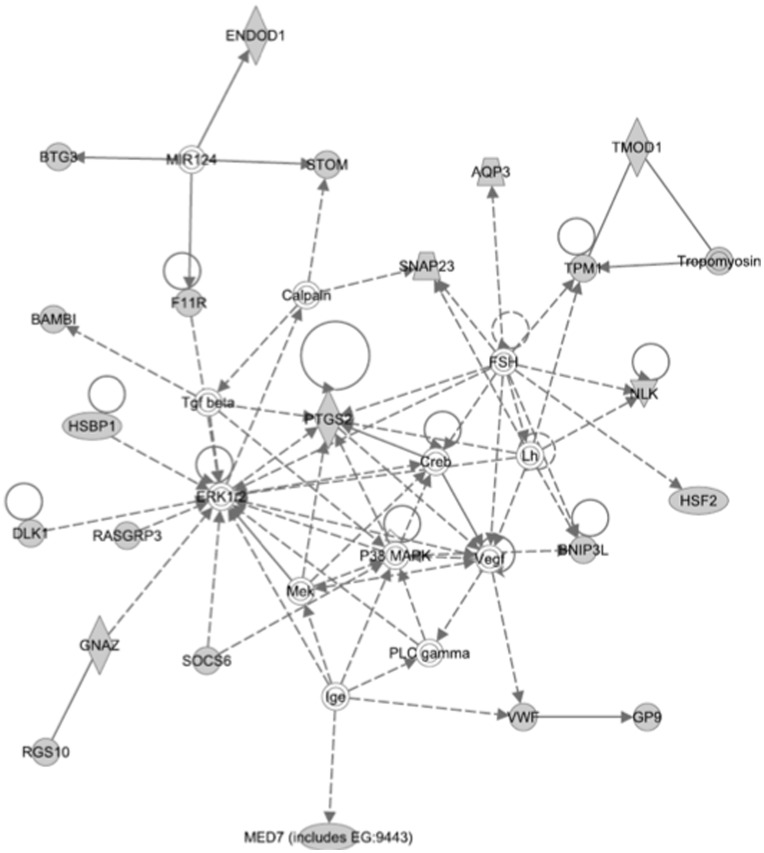
Second-highest scoring network after interactive network analysis of gene expression changes induced after hep-ATIII treatment of SIV-infected rhesus macaques.The second-highest scored network activated by hep-ATIII treatment of chronically SIV-infected rhesus macaques, at a time point when viral replication is inhibited by hep-ATIII (day 7), is shown. Network analysis was performed using Ingenuity 8.0 software. Explanation for symbols is given in Figure S2.